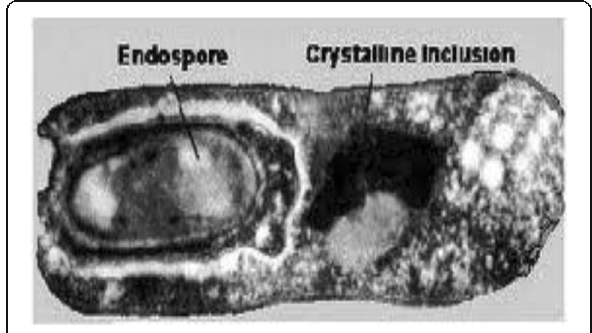
Fig. 1 The spore of Bacillus thuringiensis “ from Hofte and Whitely (1989)